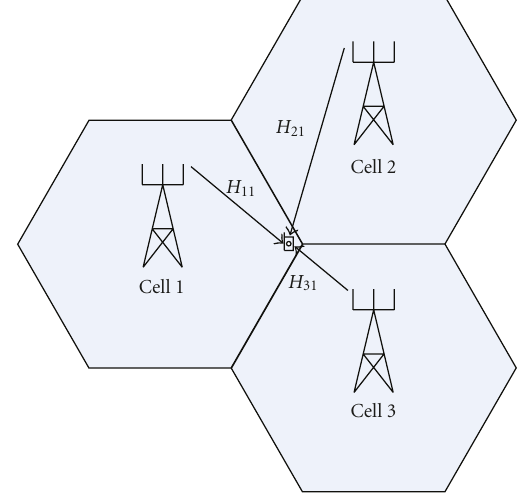
Figure 7: Coordinated multipoint transmission in the